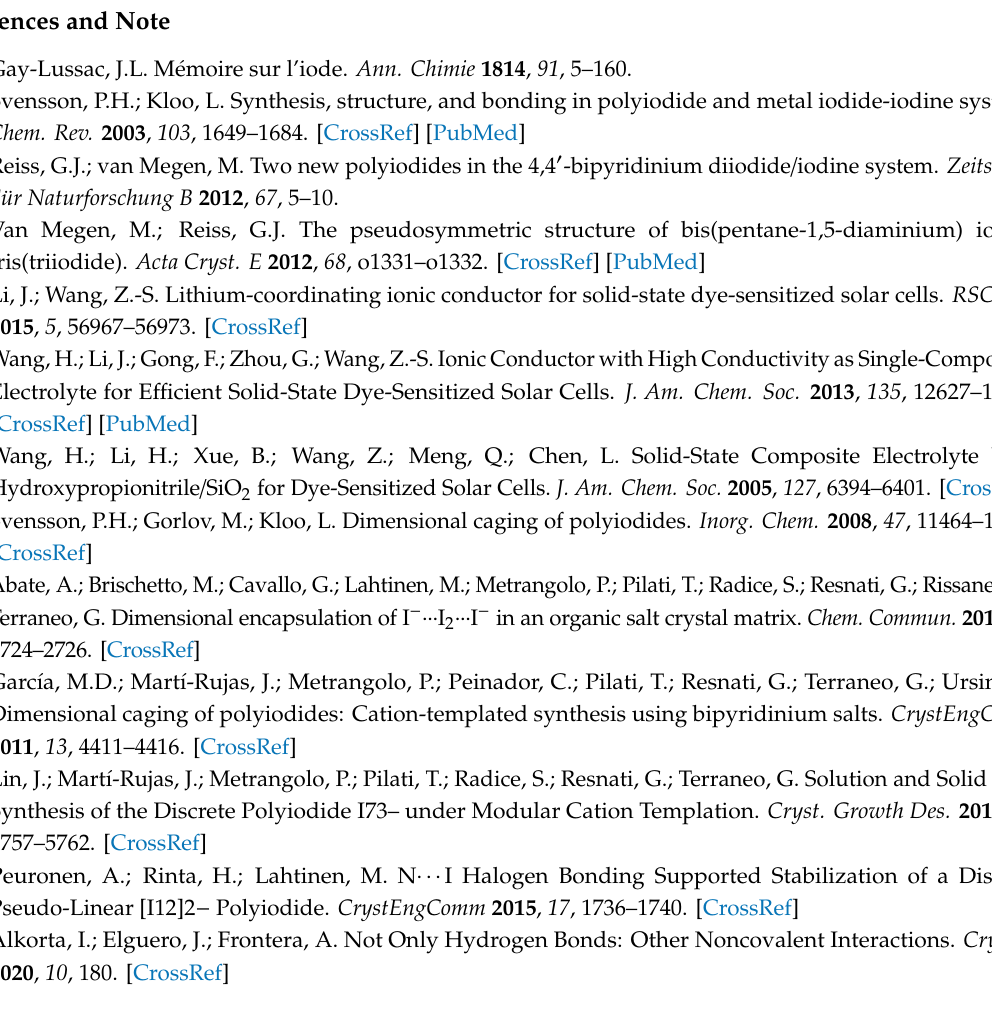
Table S1: Crystallographic information; Table S2: Selected contacts for the I 3 @BB(I 3 ) 3 · 2DMSO crystal structure; TableS3: OverviewofBBcontactsintheexaminedcrystalstructuresaccordingtoHirshfeldsurfaceanalysis; FigureS1: Synopsis of fingerprint plots. CCDC deposition number 1996957 contains the supplementary crystallographic data for this paper. These data can be obtained free of charge via http: // www.ccdc.cam.ac.uk / conts /